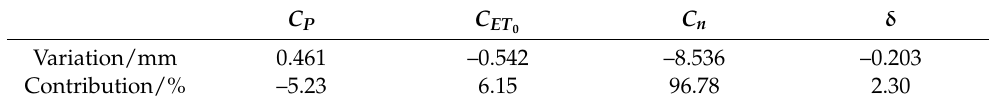
Table 4. Contribution of hydrological and meteorological elements to runoff